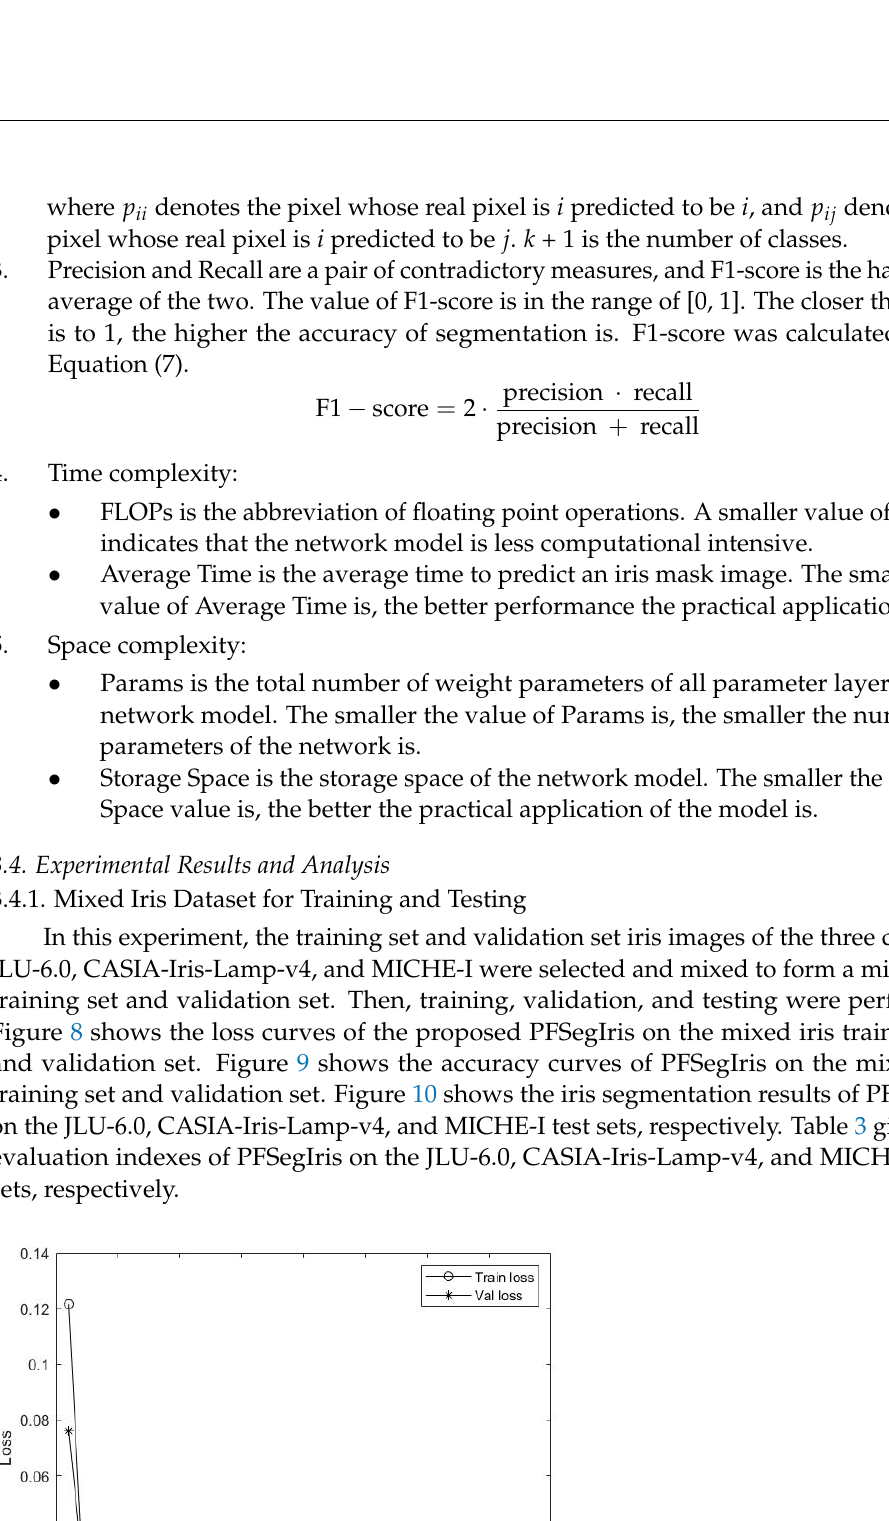
Figure 9. The accuracy curves of PFSegIris on the mixed iris training set and validation set. ( a ) ( b ) ( c ) ( d ) Figure 10. The segmentation results of PFSegIris on the JLU-6.0, CASIA-Iris-Lamp-v4, and MICHE- I test sets, respectively: ( a ) original images; ( b ) ground truth; ( c ) segmentation results; ( d ) merged images.